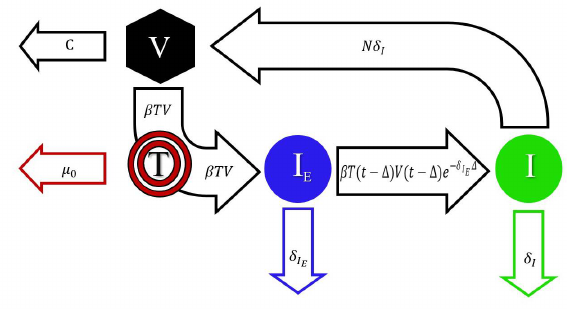
Figure 1. Flow chart of model